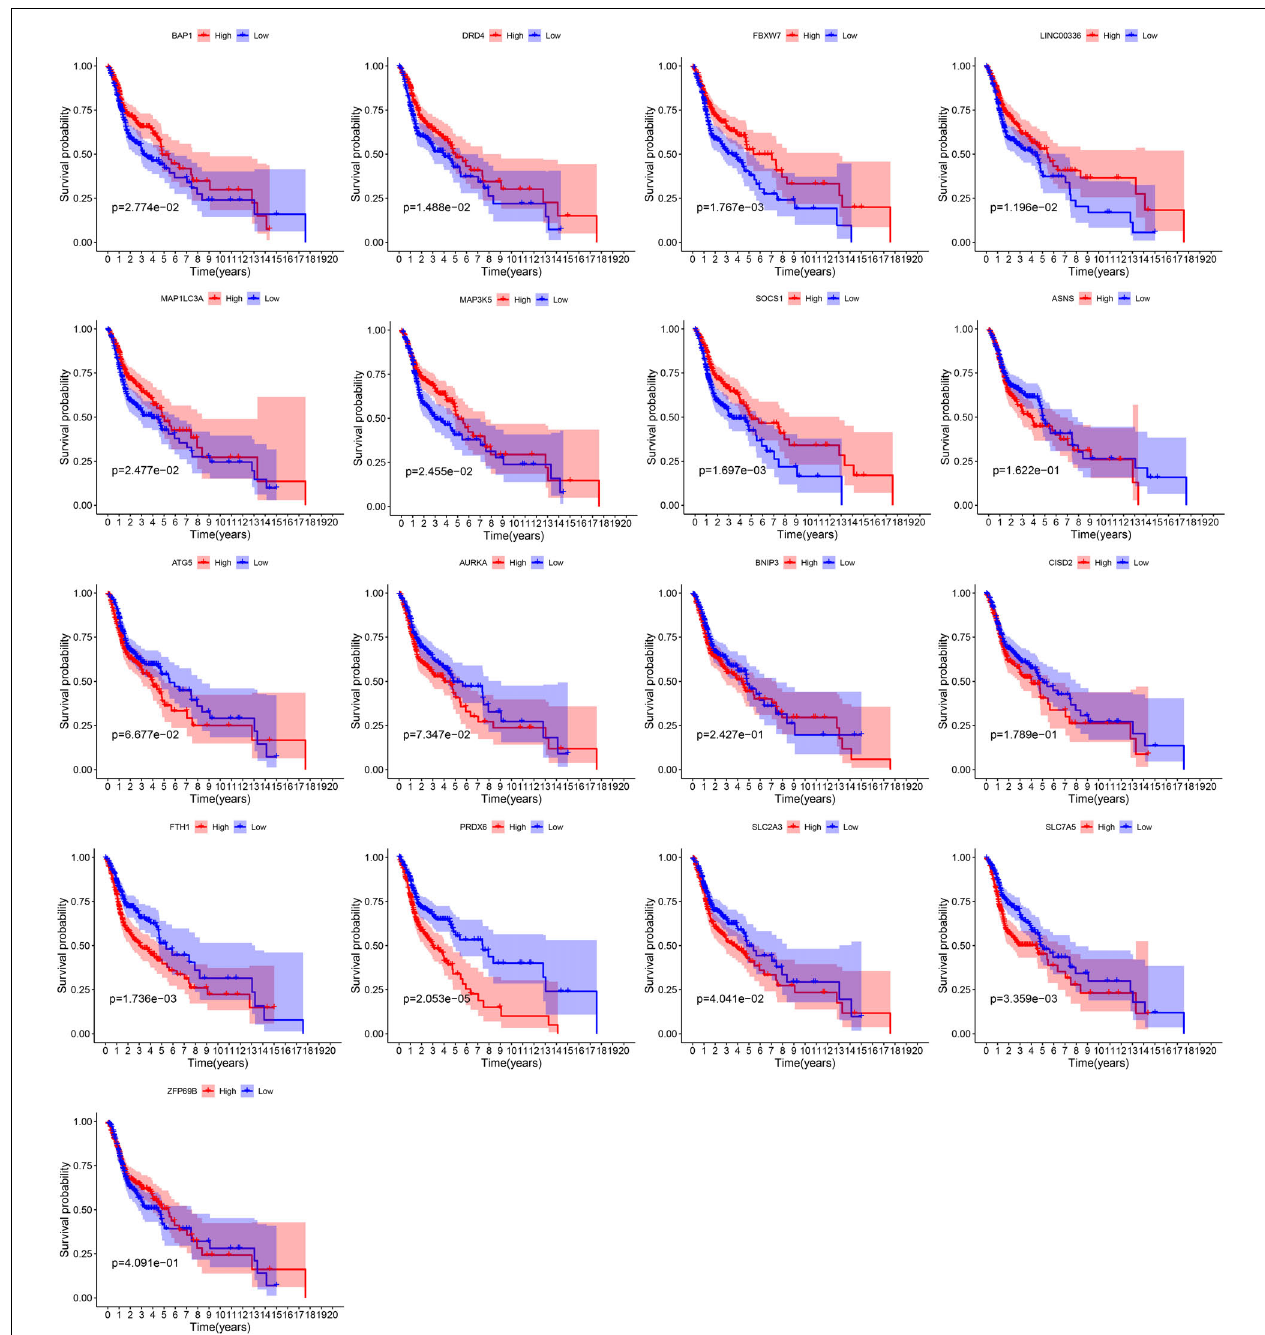
FIGURE 4 | Survival curves of 17 PR-DE-FRGs used to construct the